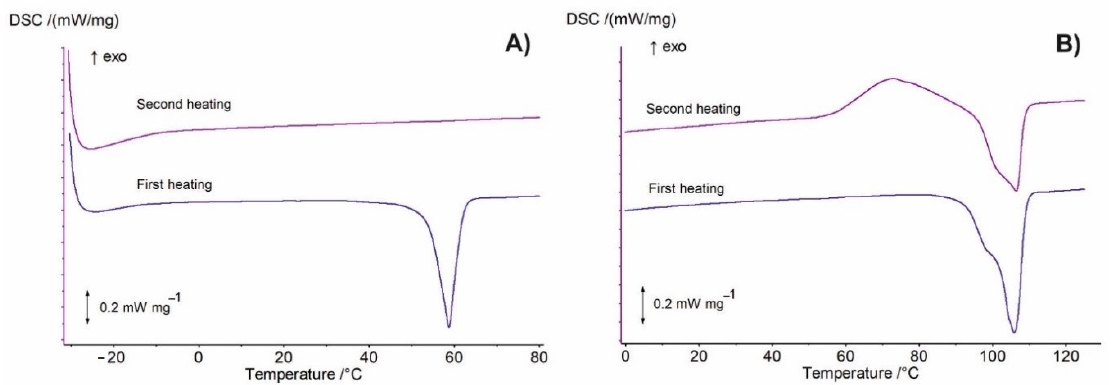
Figure 4. Data of DSC analysis for the thiacalix[4]arenes 4 ( A ) and 5 ( B ).